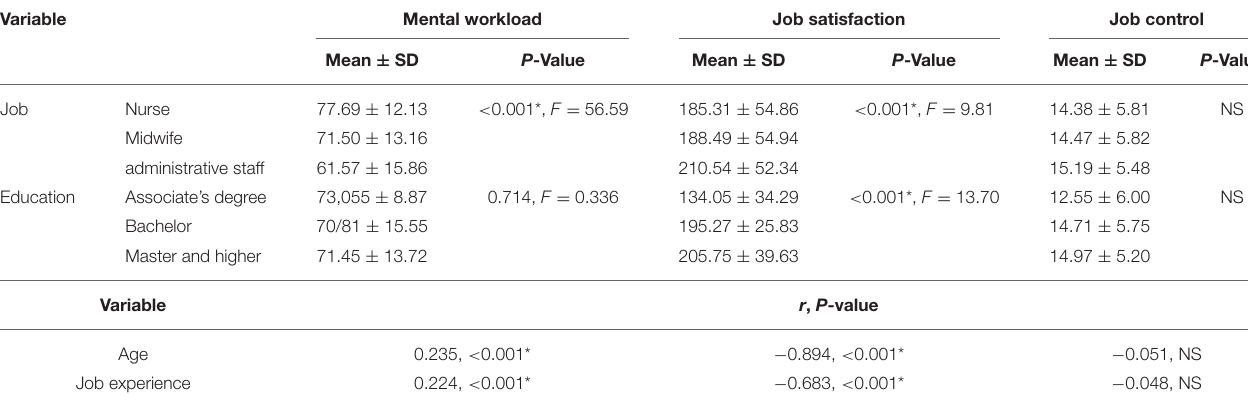
TABLE 3 | Mean of underlying variables and their relationship with workload, job satisfaction, and job control.